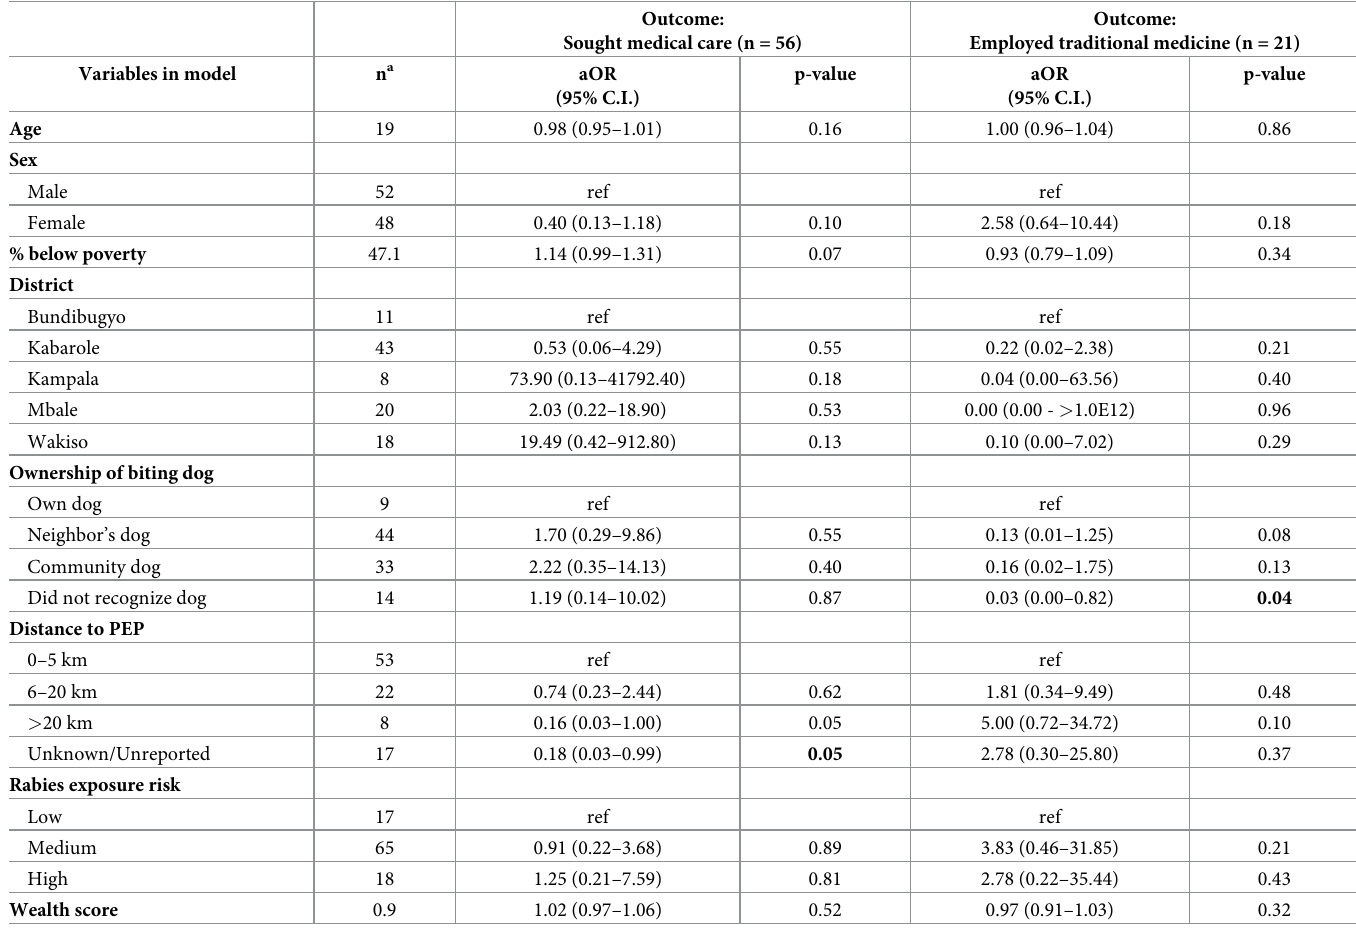
Table 7. Characteristics associated with healthcare-seeking behaviors among 100 canine-bite victims, Uganda,